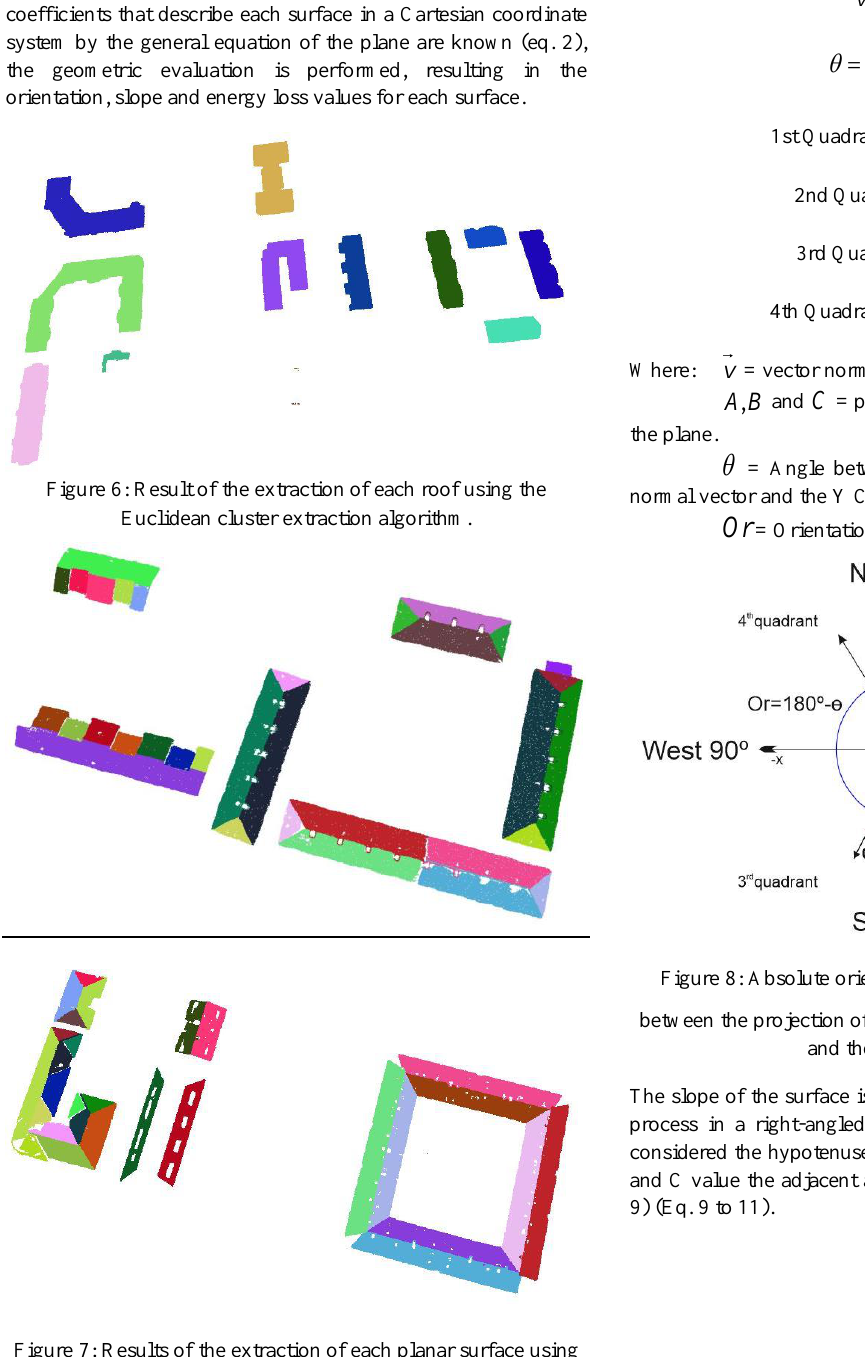
Figure 7: Results of the extraction of each planar surface using the RANSAC algorithm applied in different roofs.